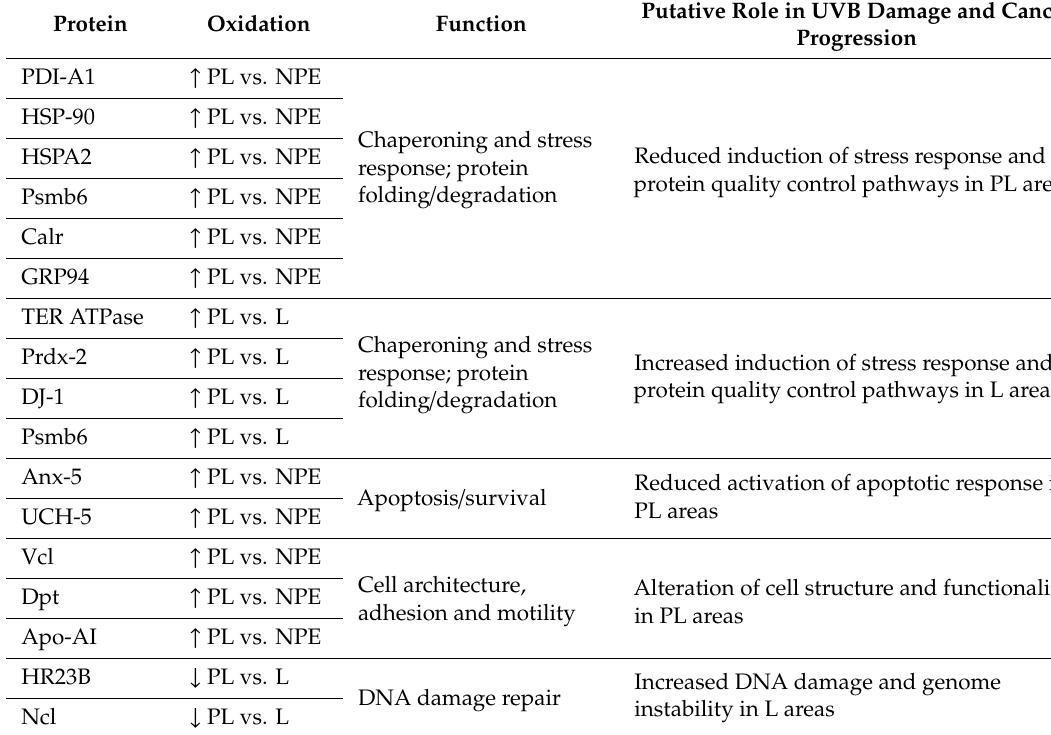
Table 3. Function and putative role in ultraviolet B (UVB) damage and cancer progression of the proteins identified di ff erentially carbonylated. The table reports only the proteins mainly involved in the carcinogenesis process. Putative Role in UVB Damage and Cancer Protein Oxidation Function